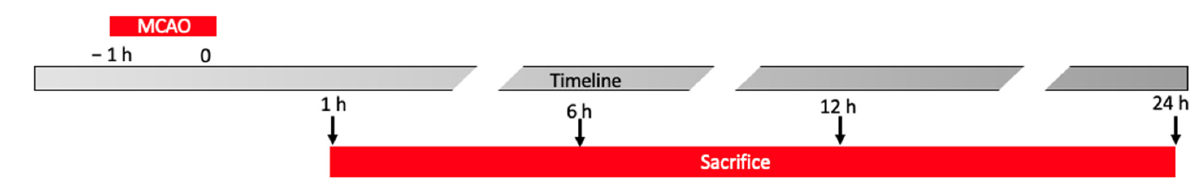
Figure 1. Experimental protocol 1.